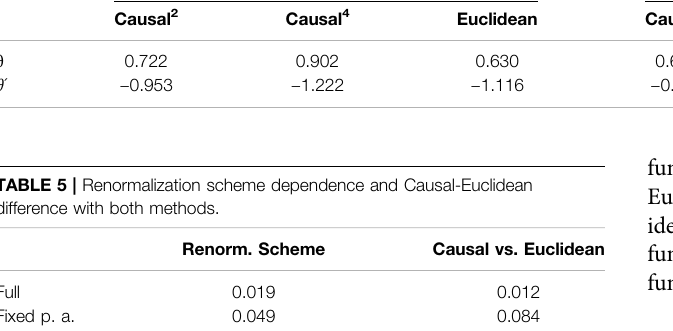
TABLE 4 | Numerical values obtained for critical exponents using the fi xed point approximation. Causal 2 corresponds to values computed using (21) and Causal 4 corresponds to the ones computed using (LABEL:c4). δ δ -mod.